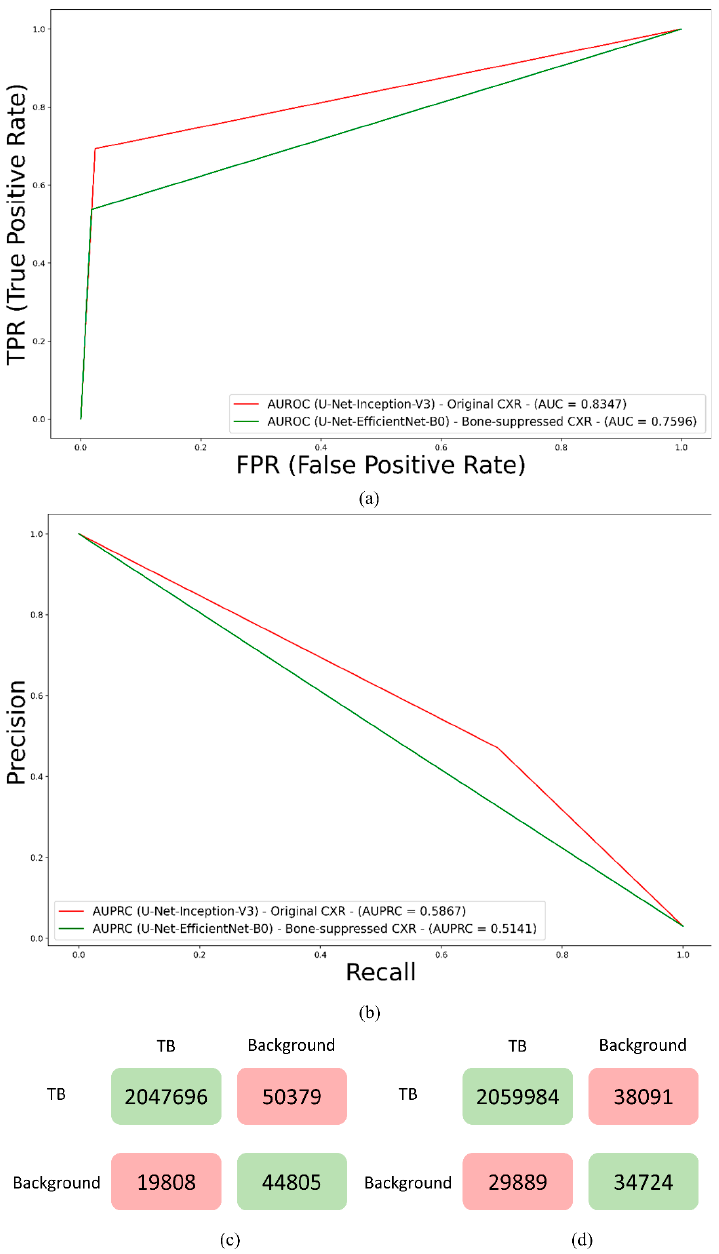
Figure 3. Performance of the top-performing U-Net with Inception-V3 encoder backbone trained on original CXRs and EfficientNet-B0 encoder backbone trained using bone-suppressed CXRs. ( a ) ROC curves; ( b ) PR curves; ( c ) Confusion matrix achieved with original CXRs, and ( d ) Confusion matrix achieved with bone-suppressed CXRs.